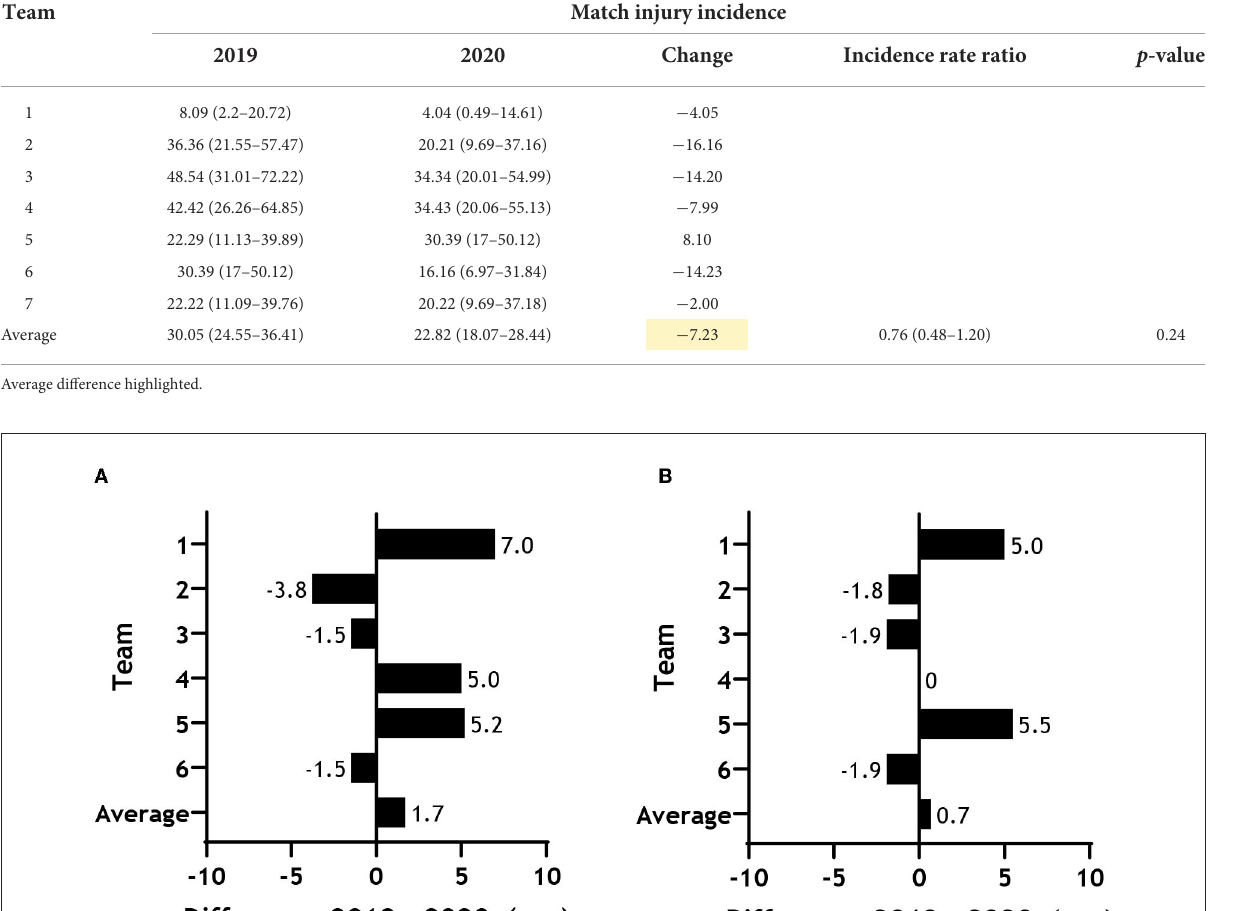
TABLE 3 Match injury incidence in the 2019 and the 2020 seasons.